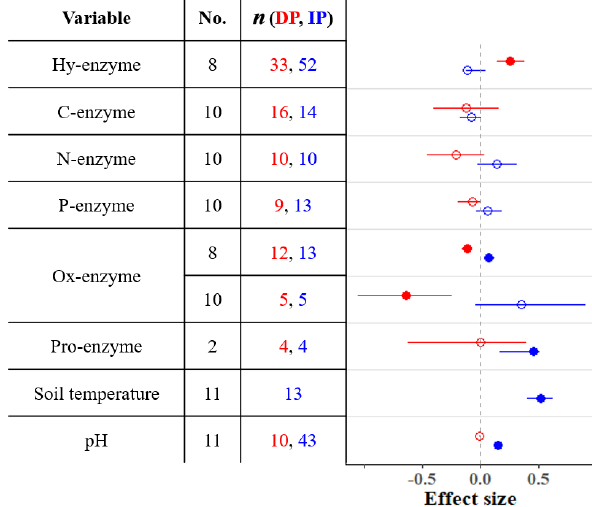
Figure 2. Effect sizes for soil enzyme and physical variables with respect to decreased (red) and increased (blue) precipitation. Filled points represent a significant effect size (95% CI not overlapping 0), and open points represent a nonsignificant effect size. Variable names correspond to Table 2. No. is meta-analysis number as listed in Tables 1 and 2. The sample size is indicated by n